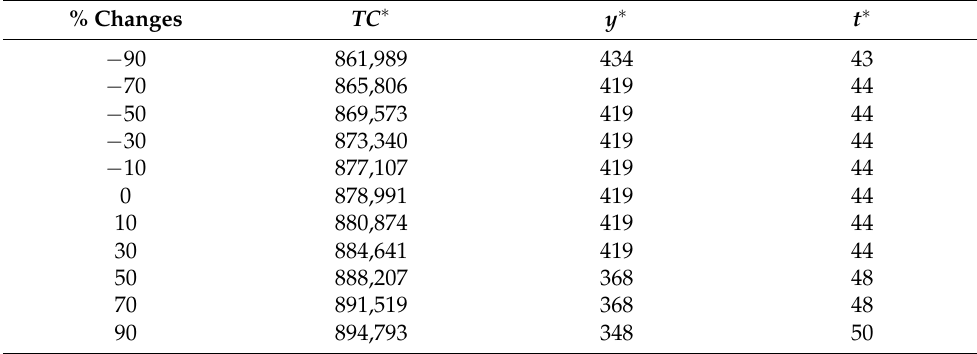
Table 6. Sensitivity analysis of the purchasing cost ( p